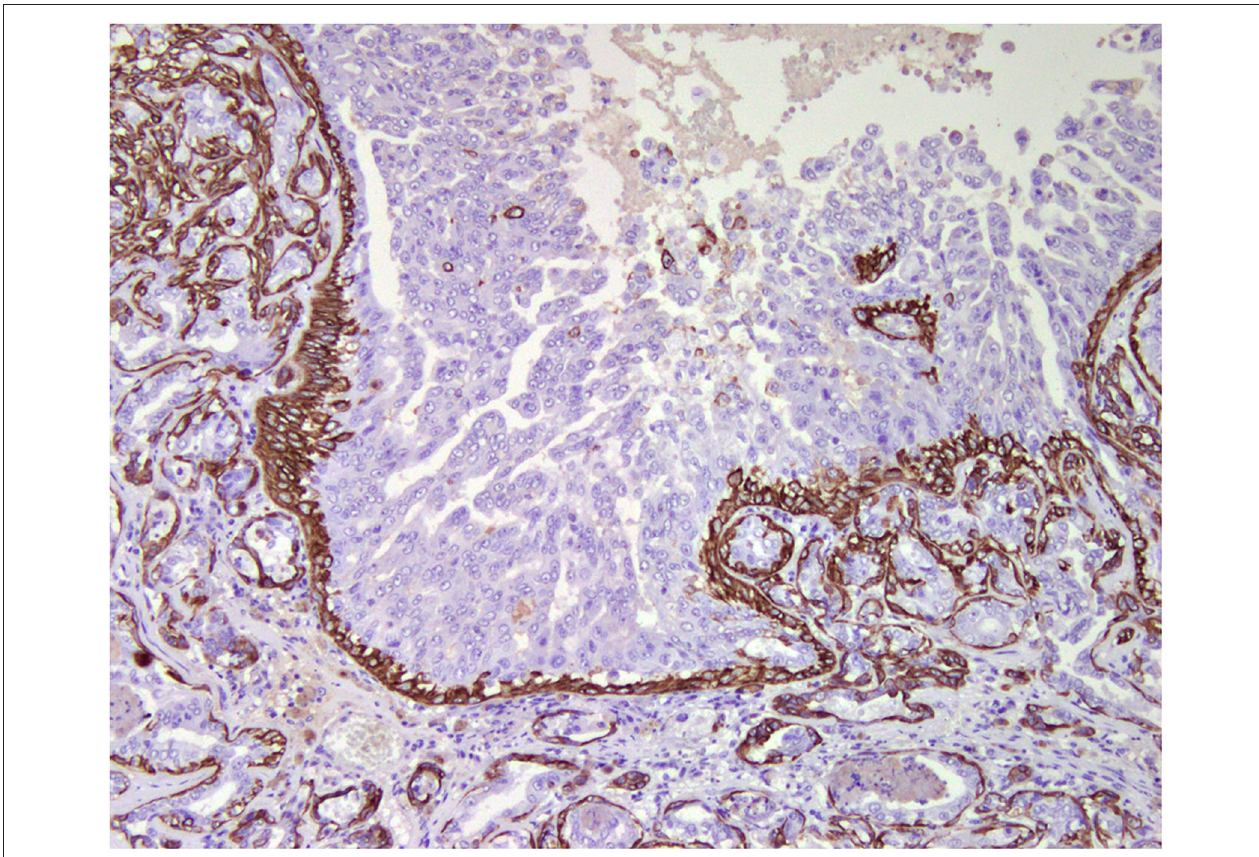
FIGURE 2 | Tubulo-papillary carcinoma, mammary gland, dog. Immunohistochemical cytoplasmic staining of cytokeratin 14. Basal/myoepithelial cells are positive.